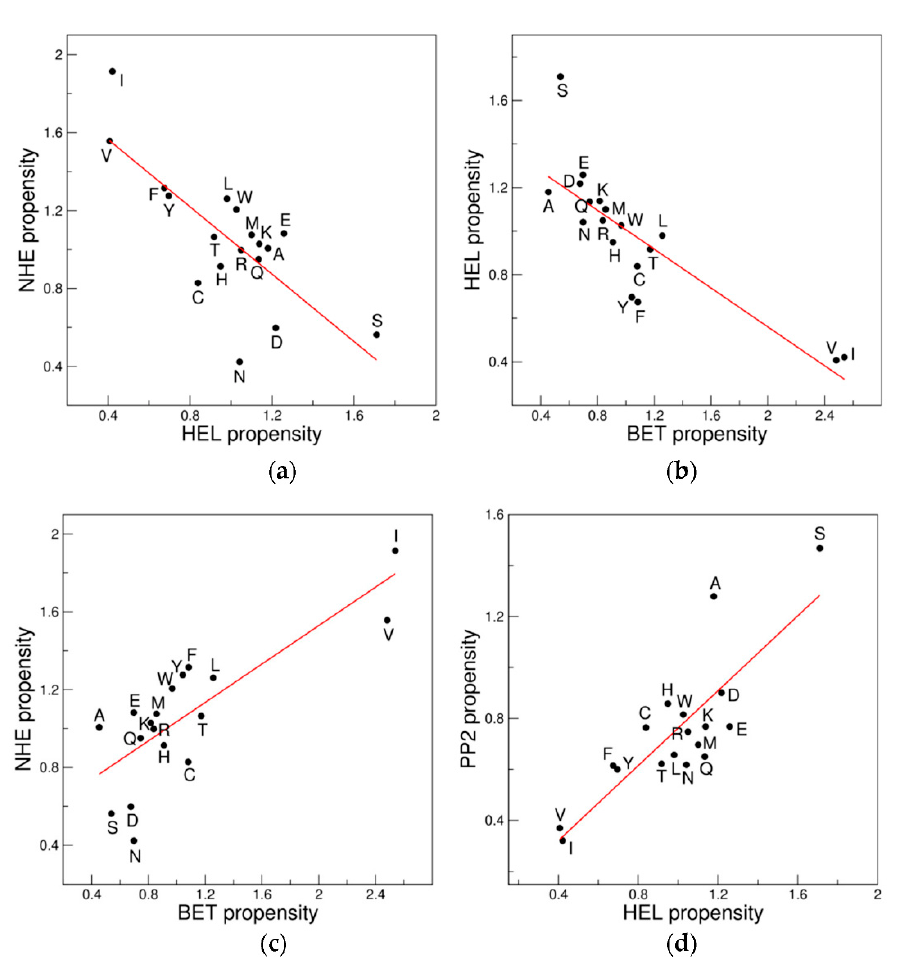
Figure 4. Examples of correlation/anticorrelations of the propensity scales of the clusters: ( a ) HEL versus NHE; ( b ) BET versus HEL; ( c ) BET versus NHE; and ( d ) HEL versus PP2. The 18AA ensemble is considered.